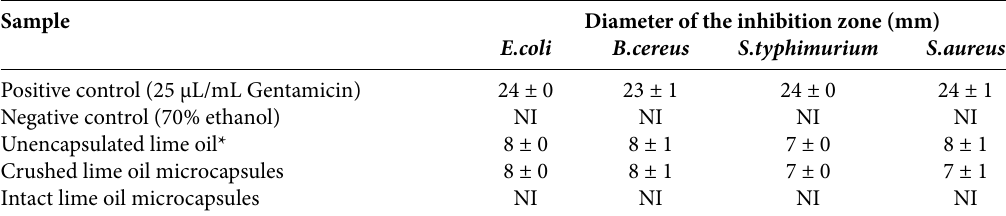
Table 3. Diameter of the inhibition zones for bacterial species with different lime oil samples Sample